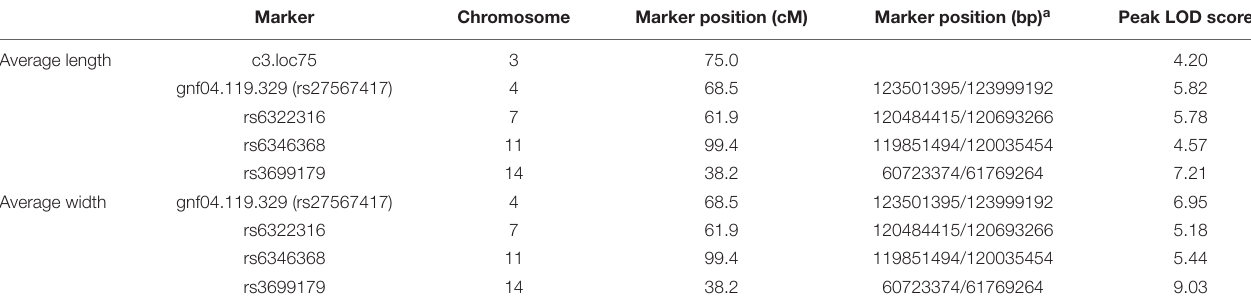
TABLE 2 | QTL mapping of IF. Marker Chromosome Marker position (cM) Marker position (bp) a Peak LOD score b Average